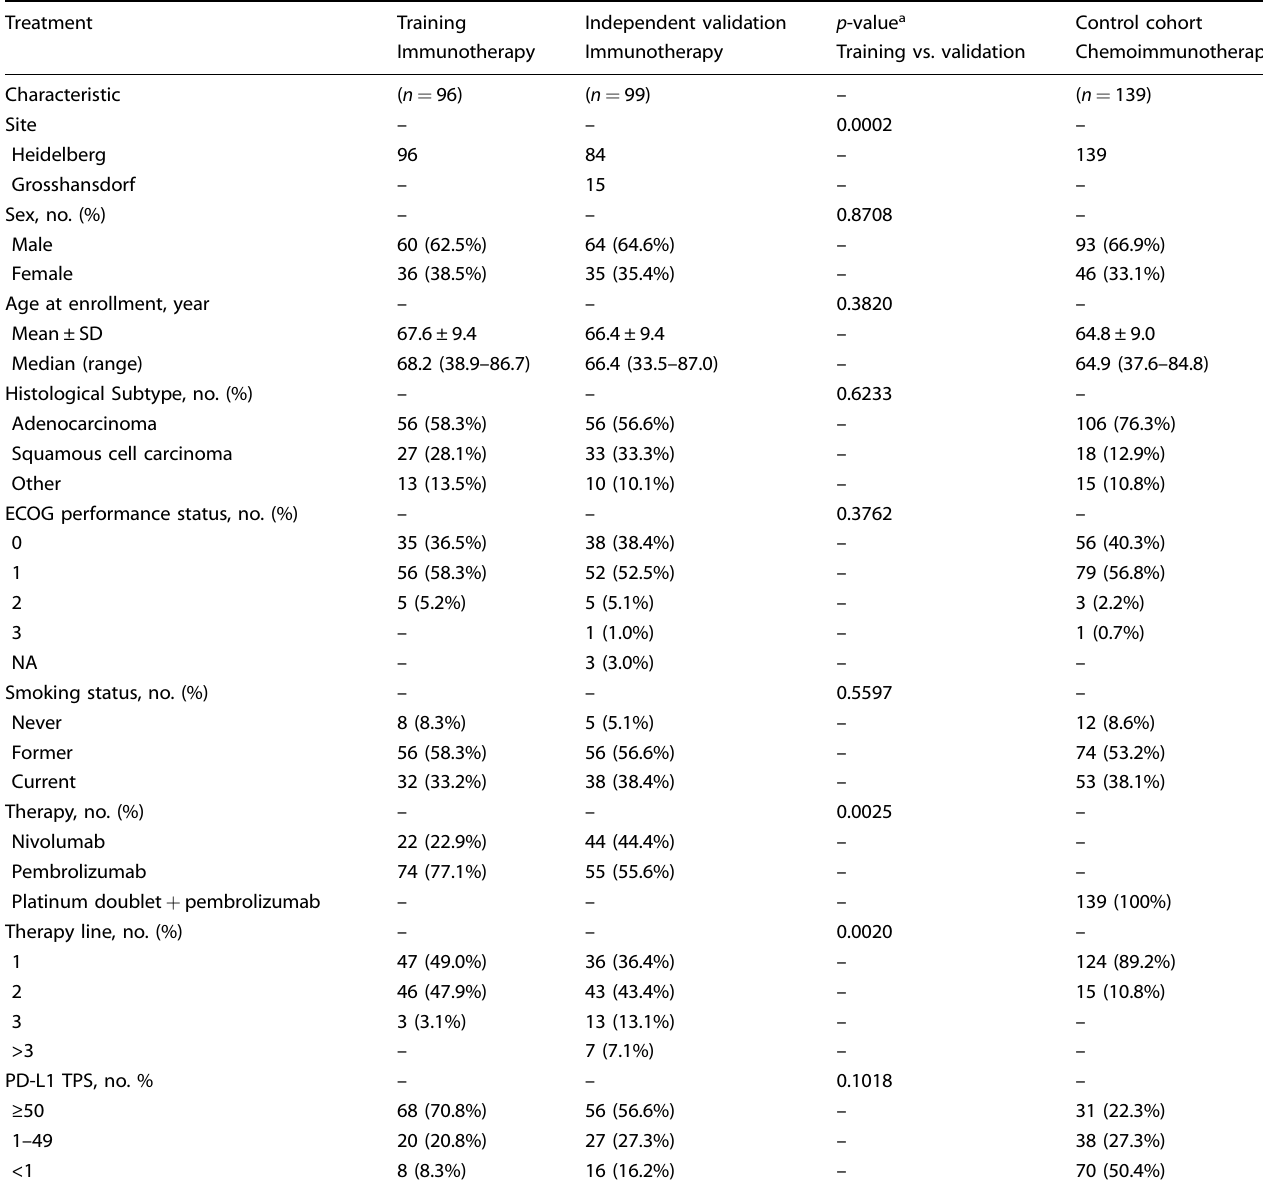
Table 1. Clinical characteristics of patient